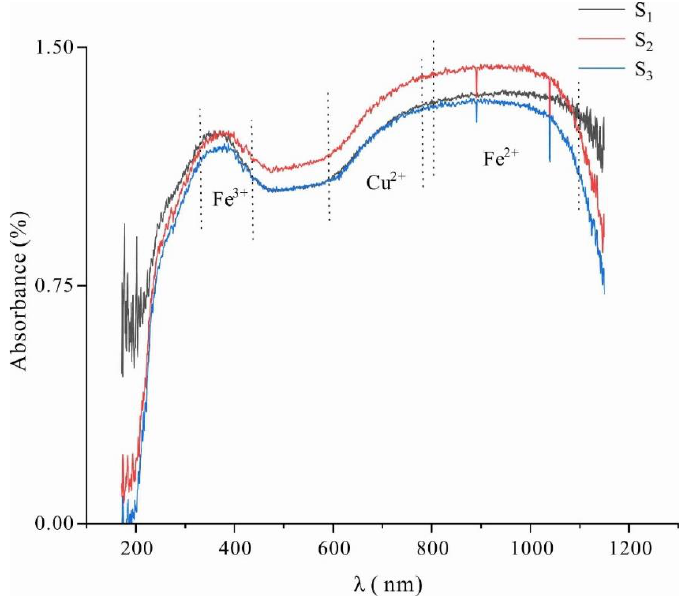
Figure 6. Ultraviolet – visible light (UV – VIS) spectra of three cabochon specimens of Lvwen stone.